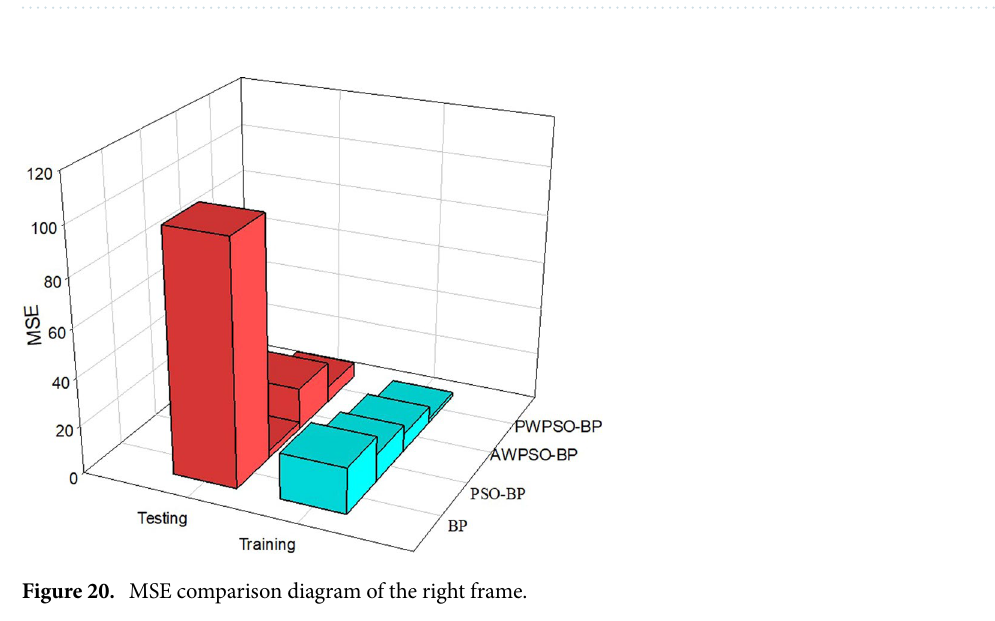
Figure 19. MSE comparison diagram of the left frame.